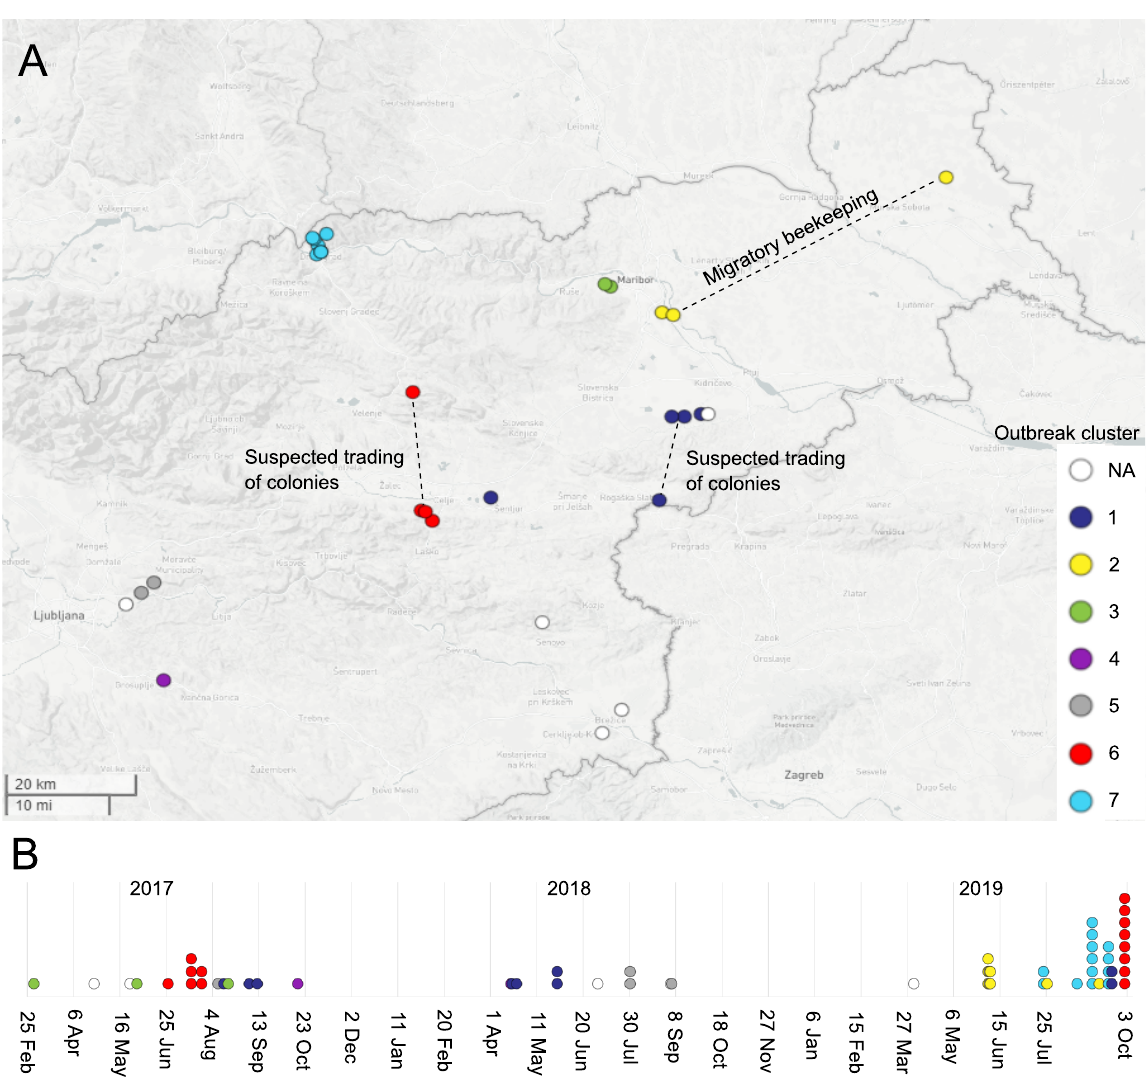
Figure 3. Map of the investigated AFB outbreaks caused by Paenibacillus larvae ERIC I-ST2 clones, Slovenia, 2017–2019. The figure shows spatial ( A ) and temporal ( B ) distributions of the 59 outbreak-related ERIC I isolates. Each circle represents an apiary ( A ) or isolate ( B ) and is colored according to the corresponding P. larvae outbreak cluster; the isolates without an assigned outbreak cluster are denoted “not assigned” (NA). Epidemiological data supporting the transmission of the outbreak clone over large geographic areas are highlighted ( A ). For isolate metadata, see Table